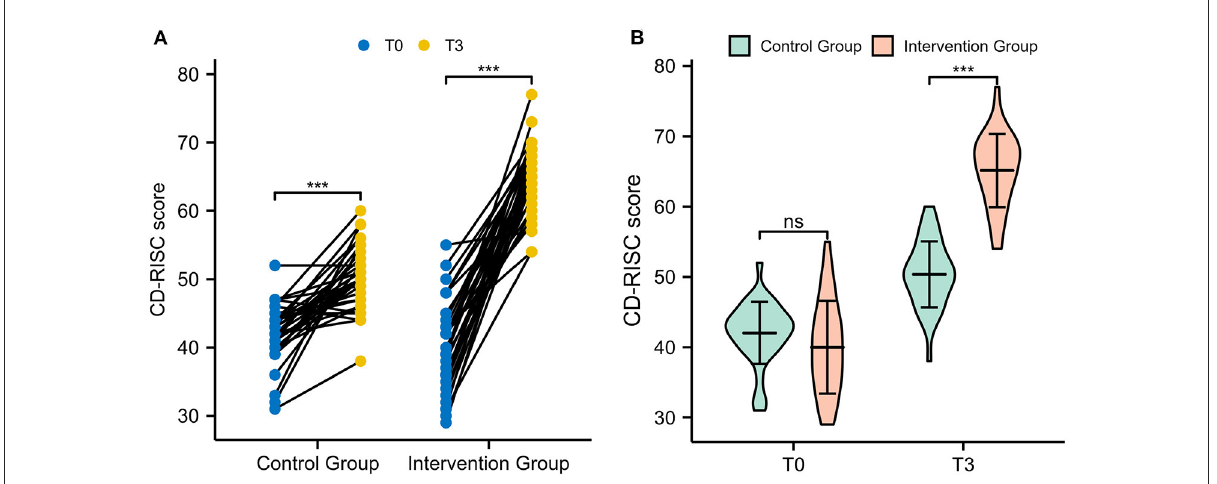
FIGURE5 The CD-RISC scores of patients. (A) Comparison of CD-RISC scores between T0 and T3 in paired samples. (B) Comparison of CD-RISC scores between the intervention group and the control